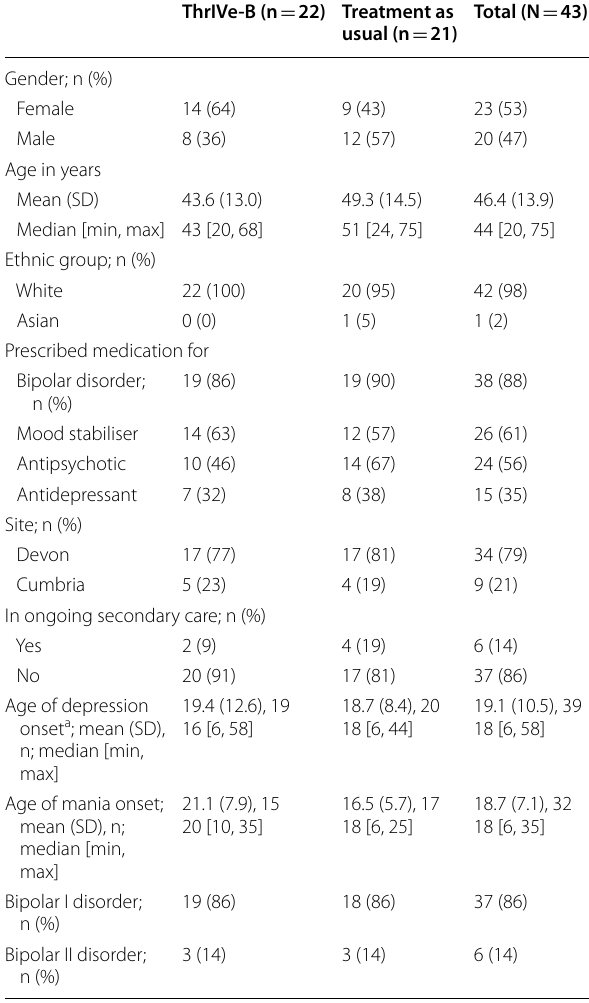
Table 1 Demographic and clinical characteristics of